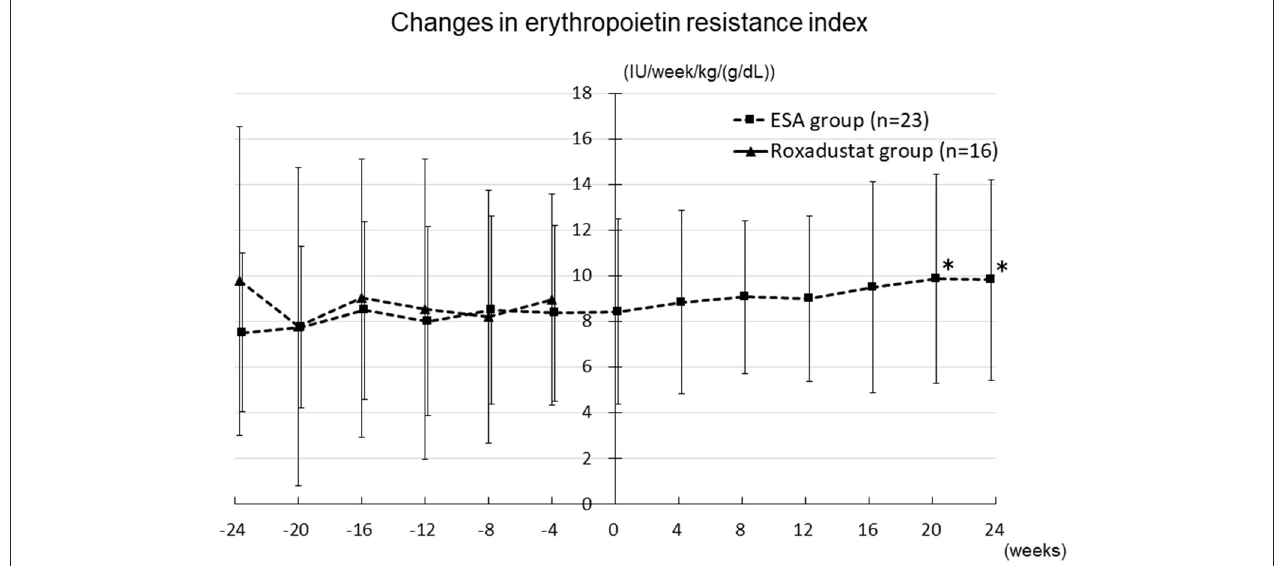
FIGURE 5 | Changes in the erythropoietin resistance index in the Roxadustat and ESA groups. ESA, erythropoiesis-stimulating agent; IU, international units; * p < 0.05 vs. − 24